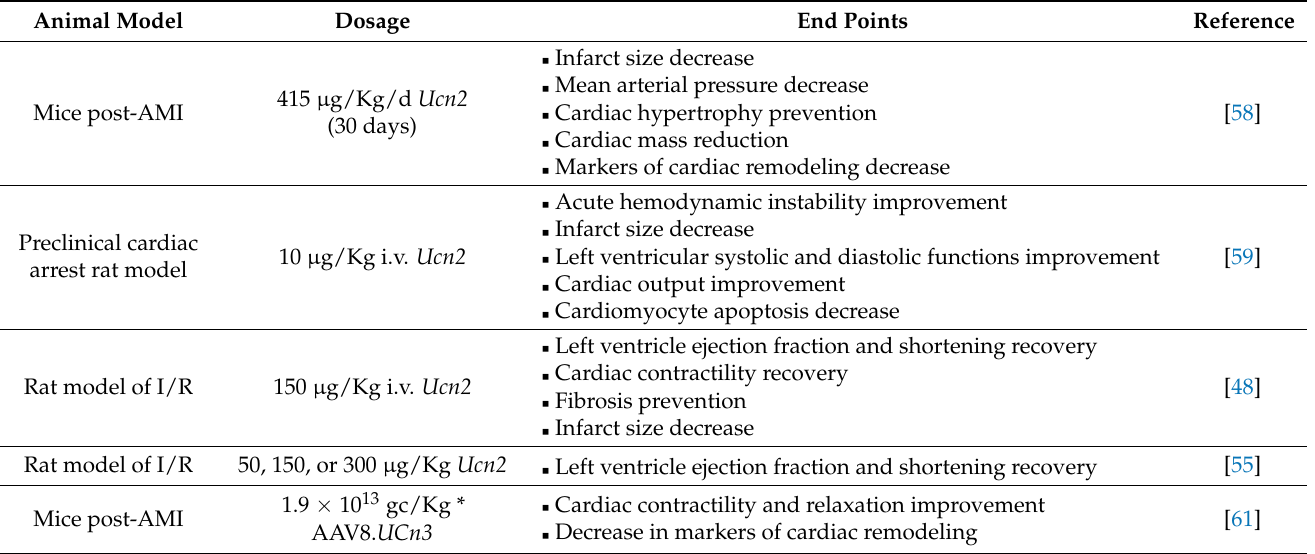
Table 2. Completed clinical trials that used Ucn isoforms.